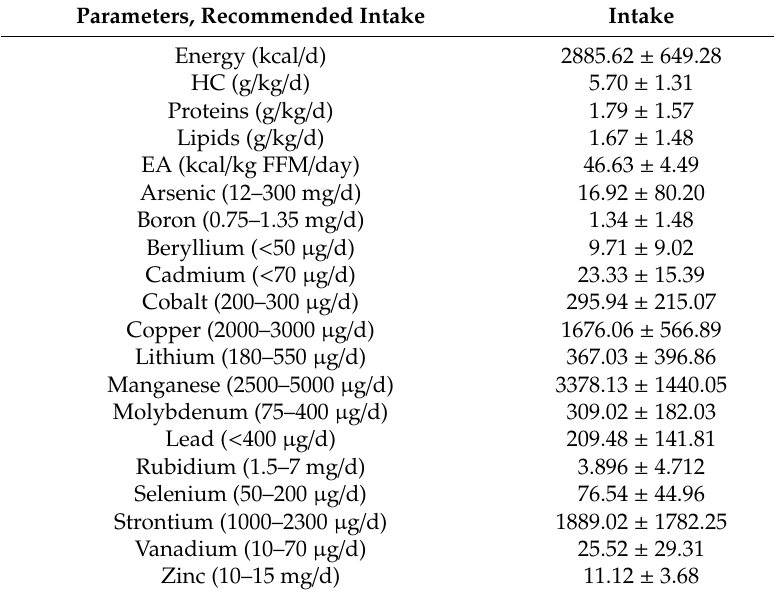
Table 2. Energy, macronutrients, and trace minerals in the runners.